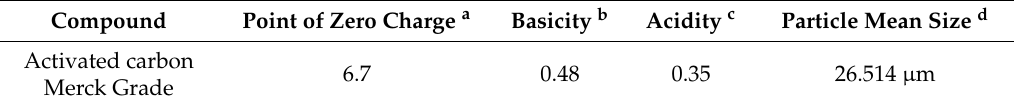
Table 5. Summary of the chemical characteristics of the activated carbon and mean particle size.